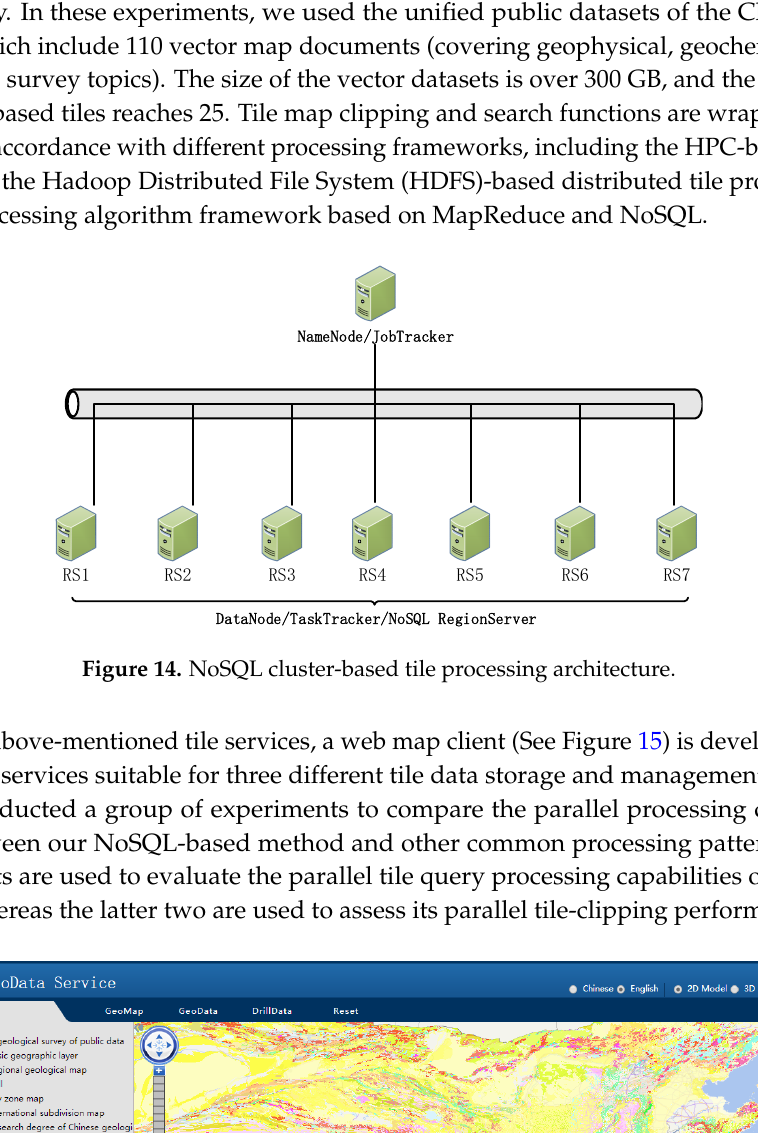
Figure 15. Web portal for the tile map of a China geological survey in the GSI Grid.